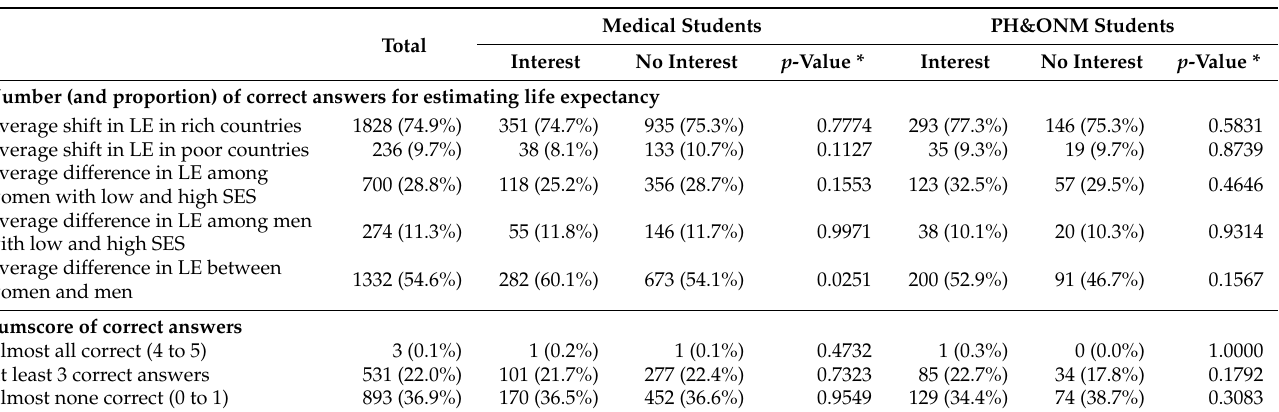
Table A3. General public health knowledge with focus on life expectancy (LE): Absolute and relative proportion of correct answers to estimated differences in LE by field of study and PHS interest in wave 1,